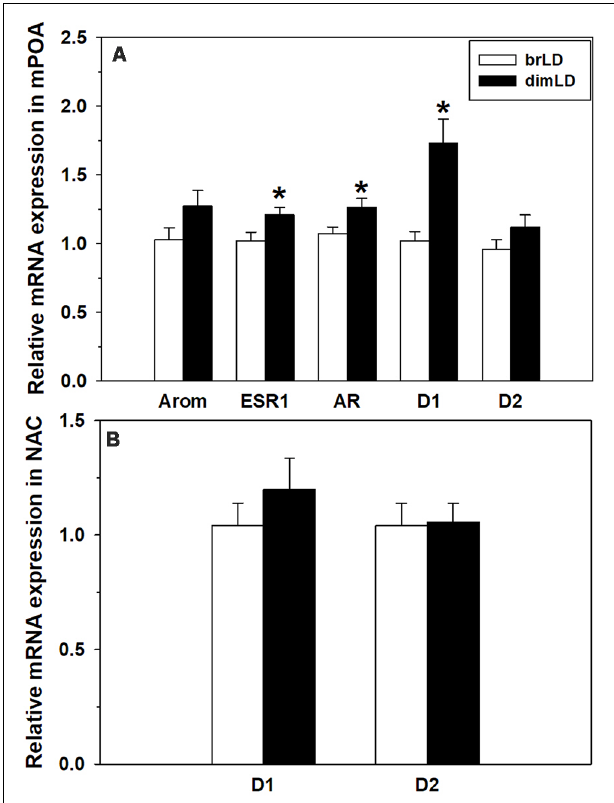
FIGURE 3 | Neural response to dim daylight. (A) Relative levels (Mean ± SEM) of mRNAs for aromatase (Arom), estrogen receptor 1 (ESR1), androgen receptor (AR), D1 and D2 in the medial preoptic area (mPOA) of male grass rats housed in bright daylight intensity condition (brLD) or dim daylight intensity (dimLD) condition. (B) Relative levels (Mean ± SEM) of mRNAs for D1 and D2 in the nucleus accumbens (NAC) of male grass rats housed in brLD or dimLD conditions. ∗ p <